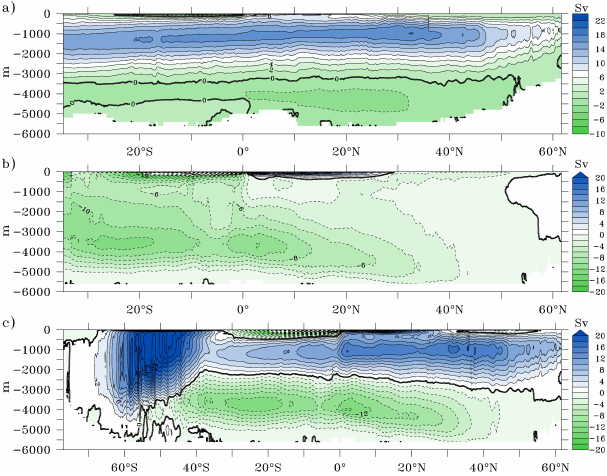
Fig. 1. Mean MOC for the 1976 to 2001 period of B025 for (a) the Atlantic, (b) the Indo-Pacific and (c) the global MOC. Contour interval is 2Sv.